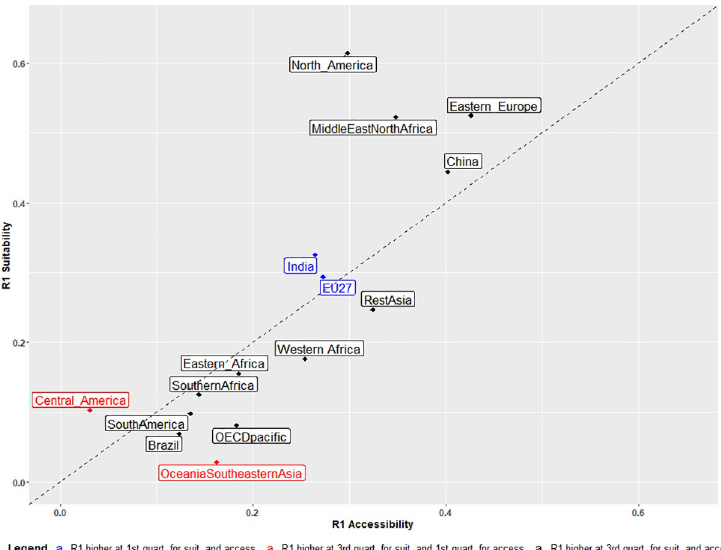
Fig 7. R1 values of quantile regression of two univariate models linking crop fraction to agricultural suitability (y-axis) and market accessibility (x-axis). The higher of the R1 values in the first and third quartiles of crop fraction distribution is reported. Values are computed at the third quartile for the regions labelled in black, at the first quartile for the regions labelled in blue, and at the third quartile regarding suitability (suit.) and the first quartile regarding accessibility (access.) for the region labelled in